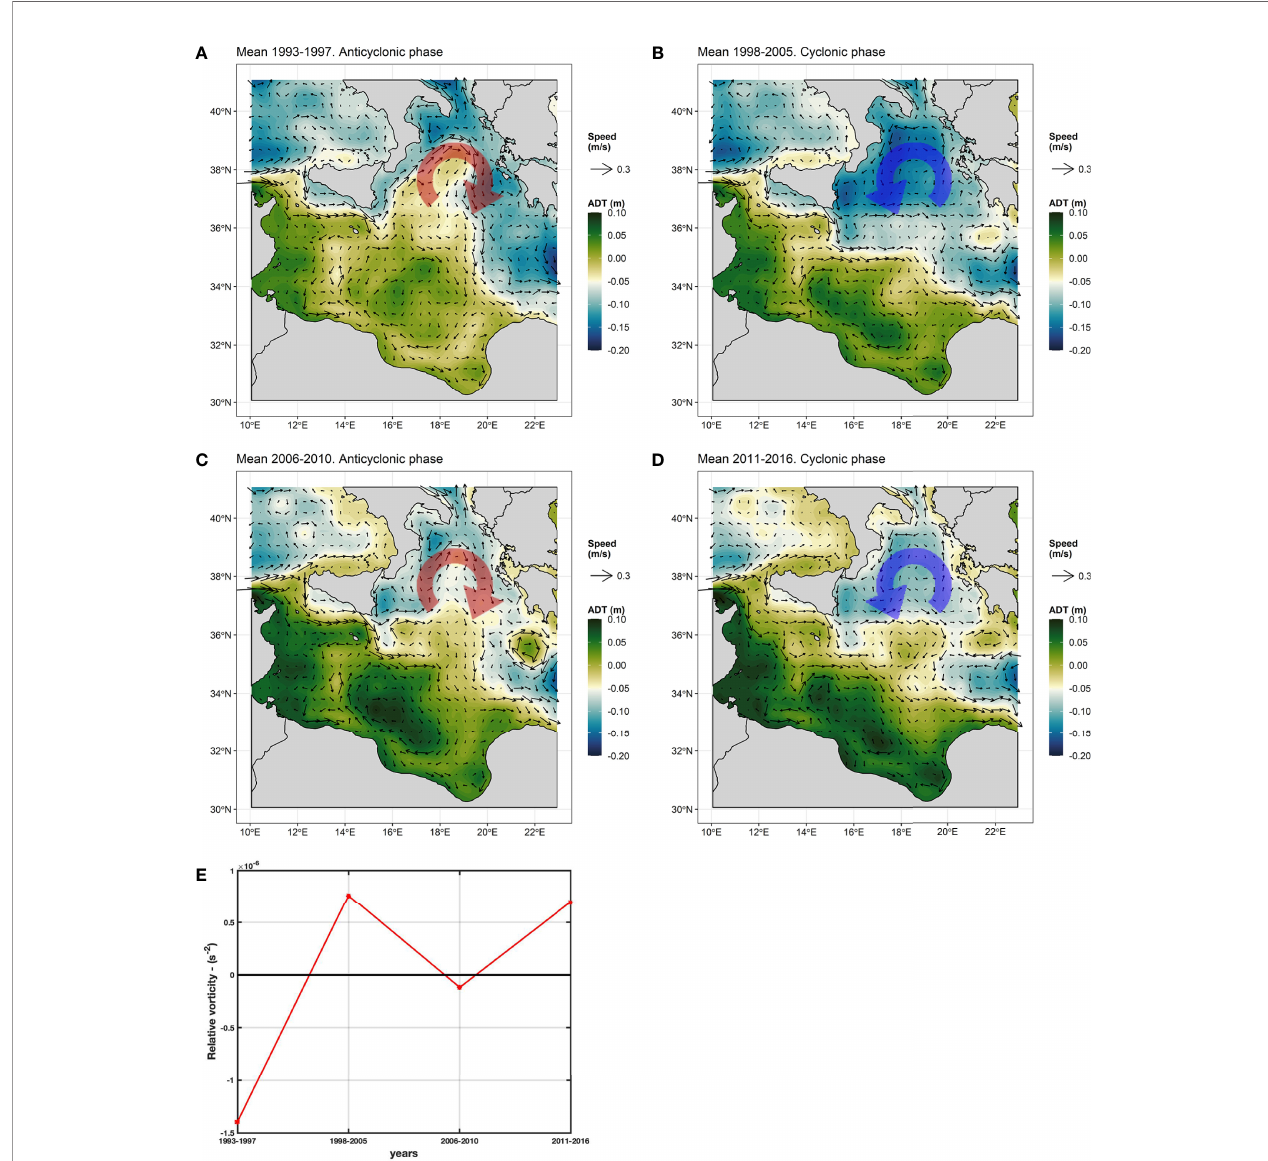
FIGURE 7 | Means map of ADT (absolute dynamic topography; colours bar) and mean geostrophic velocity fi eld (arrows) and relative speed (m/s), in the Central Mediterranean Sea, estimated for the periods (A) 1993 – 1997, (B) 1998 – 2005, (C) 2006 – 2010 and (D) 2011 – 2016. Red and blue arrows evidence the anticyclonic and cyclonic circulation mode of the North Ionian Gyre (NIG) respectively. In the panel (E) the computation of the averaged relative vorticity for the four periods con fi rms negative values (anticyclonic circulation) from 1993 to 1997 and from 2006 to 2010, and positive values (cyclonic circulation) in the periods 1998-2005 and